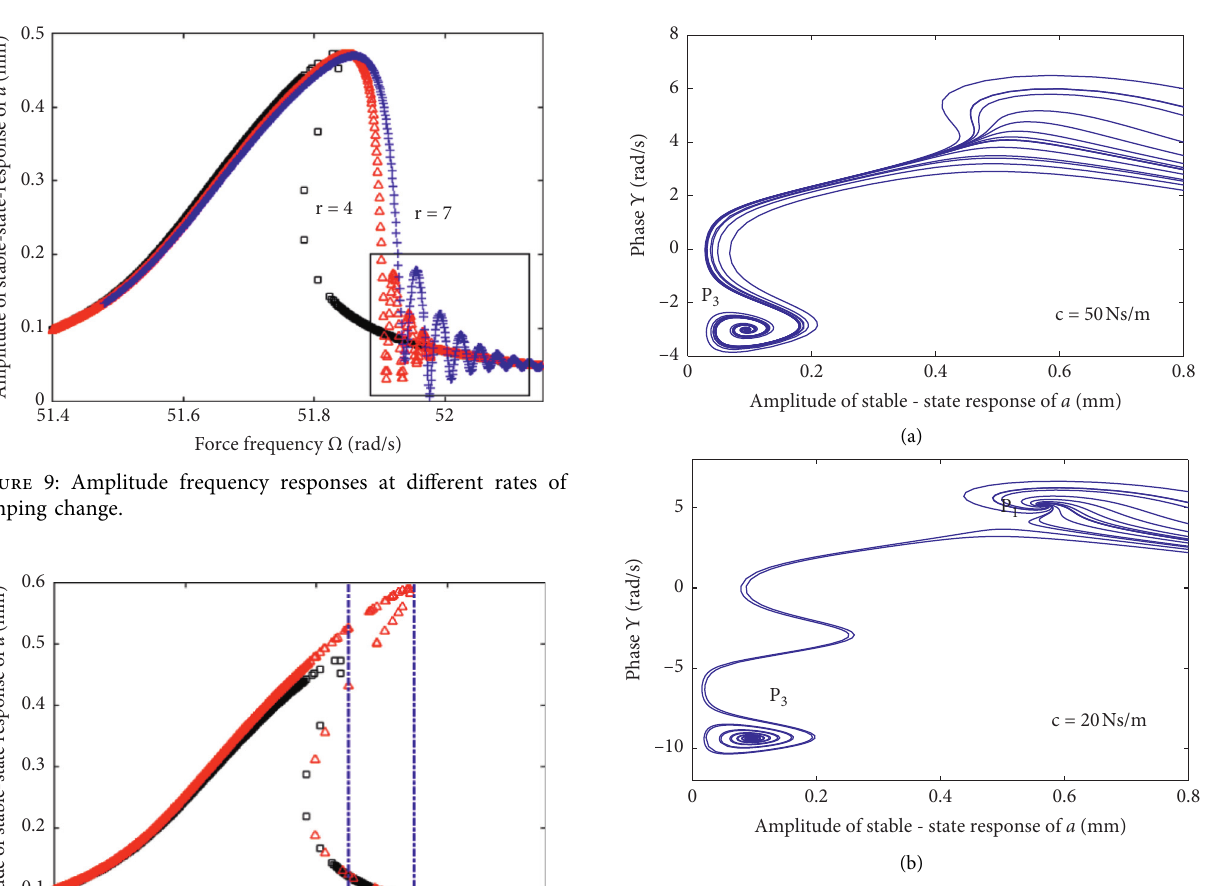
Figure 11: Stable focus before and after damping